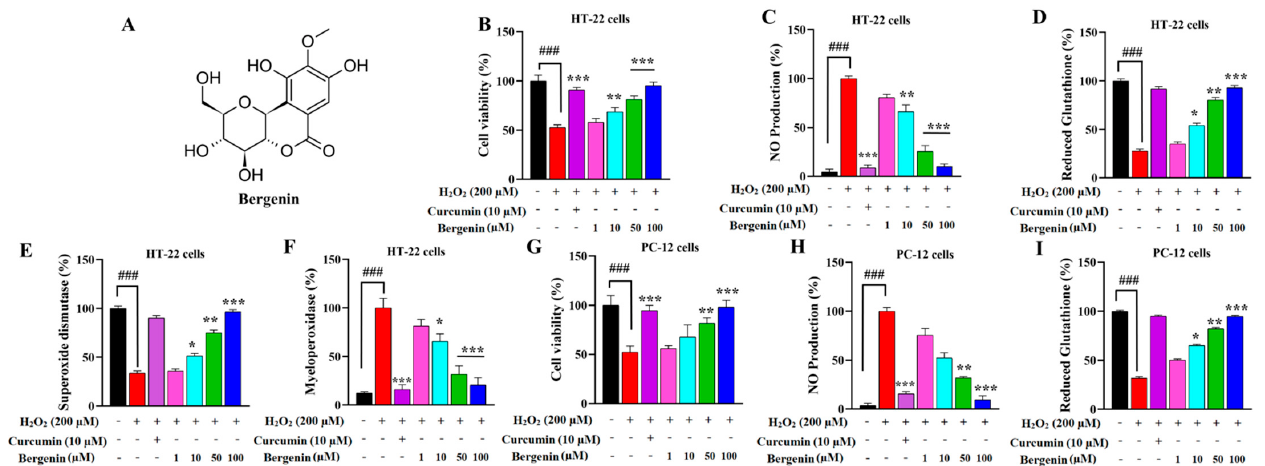
Figure 1. ( A ) Chemical structure of Bergenin. Effect of Bergenin on ( B ) (%) cell viability, ( C ) (%) nitrite production, ( D ) (%) reduced glutathione, ( E ) (%) superoxide dismutase and ( F ) (%) Myeloperoxidase level in HT-22 cells exposed to H 2 O 2 (200 µM) for 24 h. Effect of Bergenin on ( G ) (%) cell viability, ( H ) (%) nitrite production, ( I ) (%) reduced glutathione in PC-12 cells exposed to H 2 O 2 (200 µM) for 24 h. Results were expressed as mean ± S.D. * p < 0.05, ** p < 0.01 and *** p < 0.001 versus the cells exposed to H 2 O 2 alone, ### p < 0.001 versus the control (no H 2 O 2 ).